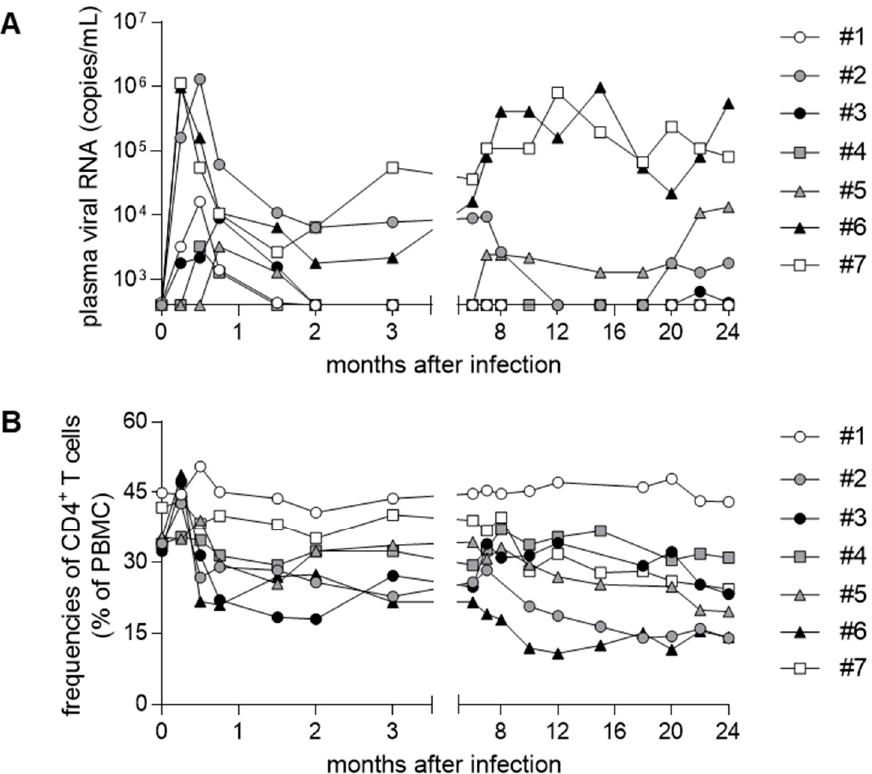
Figure 1. Plasma viral loads and peripheral CD4 frequencies in rhesus macaques after SIVsmE543- 3 infection. ( A ). Plasma viral loads (SIVsmE543-3 gag RNA copies/mL plasma) were determined as described previously [19]. The lower limit of detection is approximately 4 × 10 2 copies/mL. ( B ). Peripheral blood CD4 + T-cell frequencies. Data on viral loads and CD4 + T-cell frequencies in macaques #6 and #7 were previously reported [19], while data on the remaining five macaques have not been published.